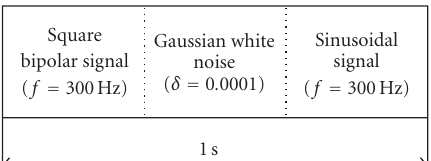
Figure 5: Initial part of test sequence.